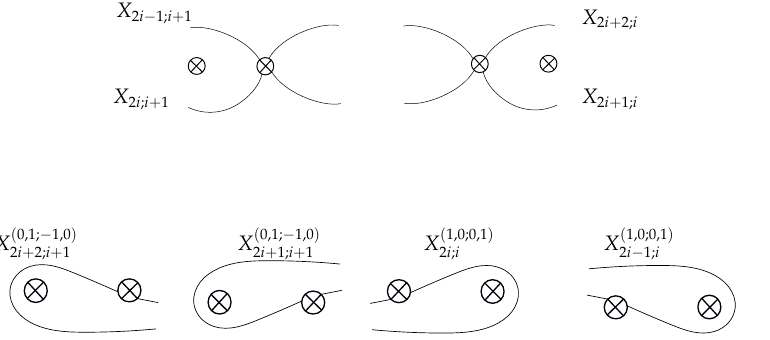
Figure 24. Arcs that are used in the computation of exceptional parameters f i , ¯ f i , g i , ¯ g i .